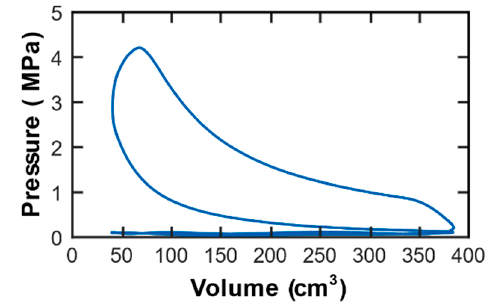
Figure 4. Simulated PV diagram for baseline engine operating at 7550 RPM and WOT mode.